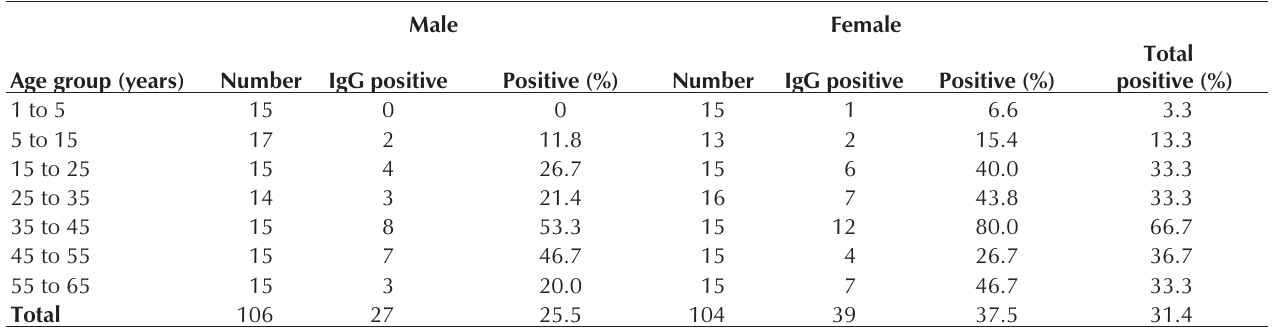
Parvovirus B19 serology among pediatric patients and Red Cross blood